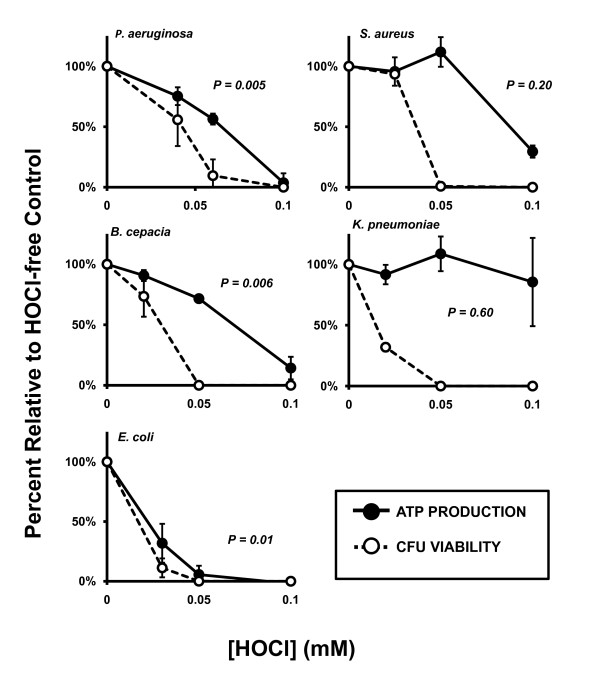
Correlating HOCl-induced ATP changes with bacterial viability. ATP production is affected by HOCl exposure and correlates statistically with CFU viability in PsA, BC, and EC (p = 0.005, 0.006, and 0.01, respectively); however, SA and KP lose CFU viability after exposure to lower concentrations of HOCl than are required to abolish ATP production during the assay time. Solid circles and lines: ATP recovery after oxidant exposure. Open circles and dotted lines: CFU viability. Both parameters are measured as percent relative to oxidant-free controls. P-values represent linear regression of the raw data values from percent ATP recovery versus CFU viability. Values less than 0.05 were considered significant and denote correlation among the parameters; values greater than 0.05 indicate independence of the parameters. Error bars represent standard deviation of at least n = 3 experiments.